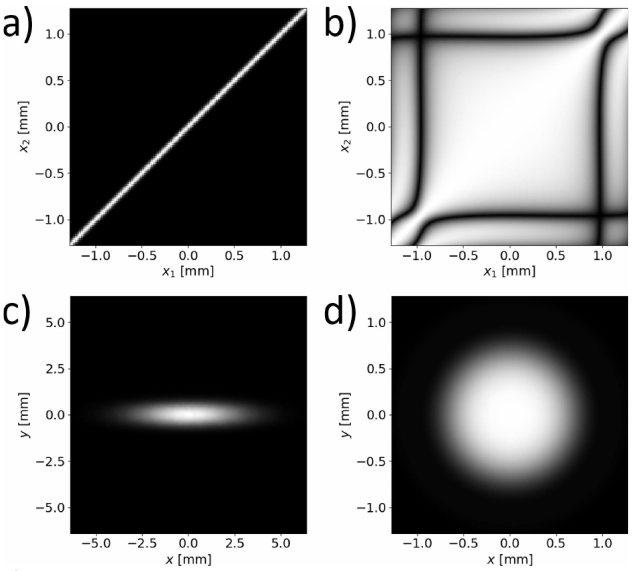
Figure 5 2D map of the horizontal SDC as a function of x 1 and x 2 for a typical third-generation synchrotron light source ( a ) and for a fourth-generation synchrotron light source close to the diffraction limit ( b ). The vertical position of the two observation points is y 1 = y 2 = 0. The corresponding SDs are reported in ( c ) and ( d ), respectively.